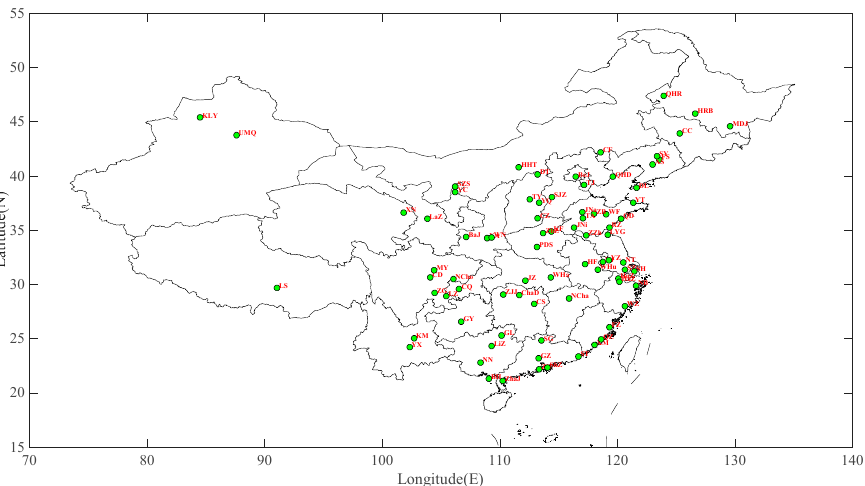
Figure 1. The computing area and the locations of the 80 sample cities during the experimental period. Full names of these cities can be found in [25].